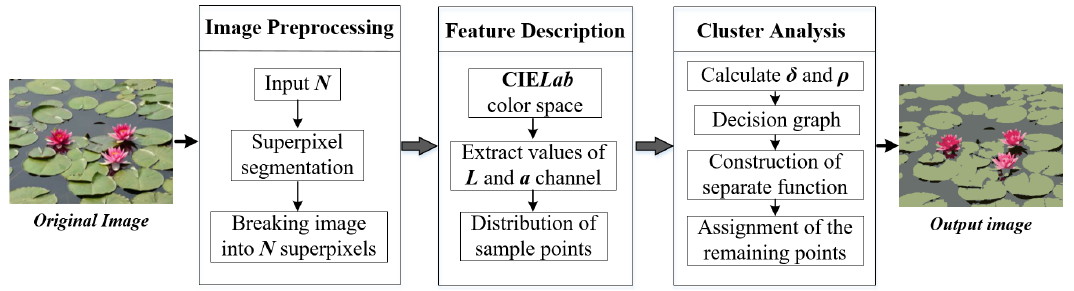
Figure 1. Overview of our image segmentation